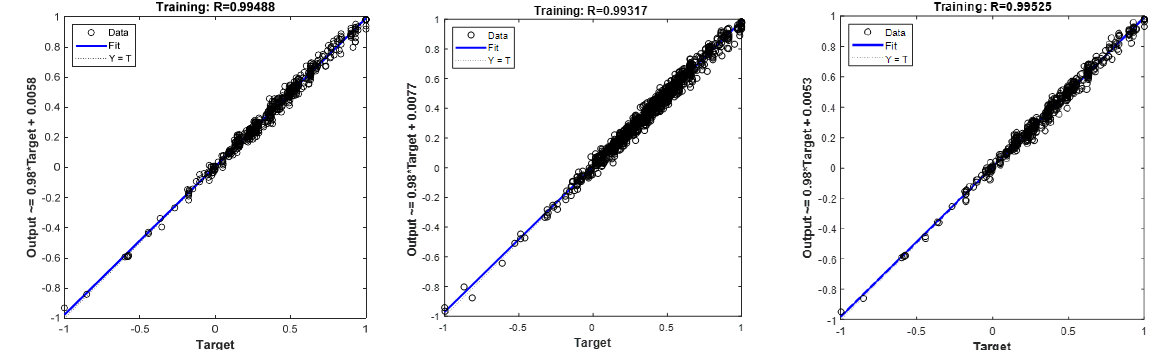
Figure 7. Residual images of ANN training on DO, CODMn, and NH 3 -N datasets.